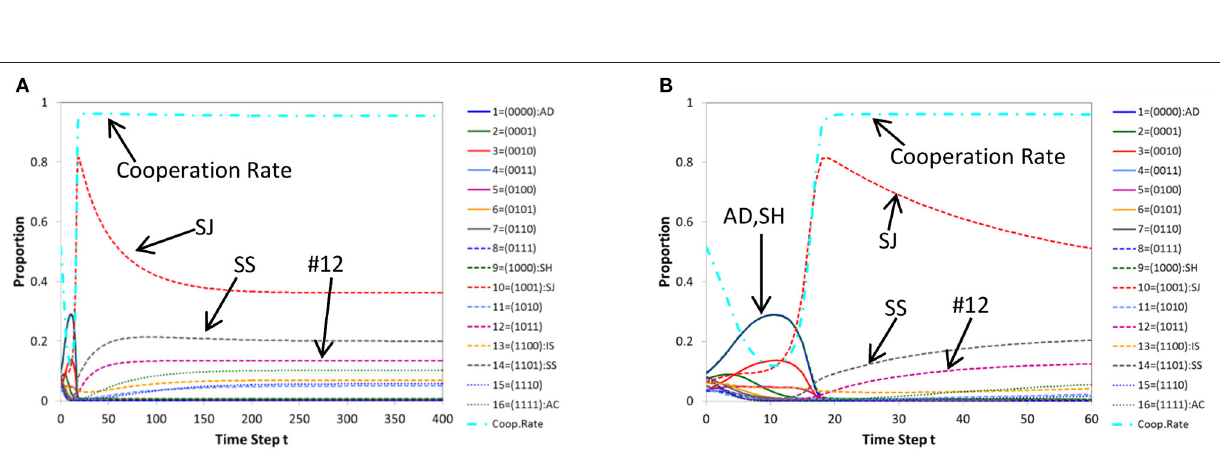
FIGURE 5 | A typical pattern of time evolution of norms’ frequencies and the cooperation rate in the population generated by genetic algorithm with a single parent (A) and its initial part (the first 60 steps) (B) for a case where cooperation is achieved. Parameters: c = 1, b = 7, µ = 0.01, dt = 1.